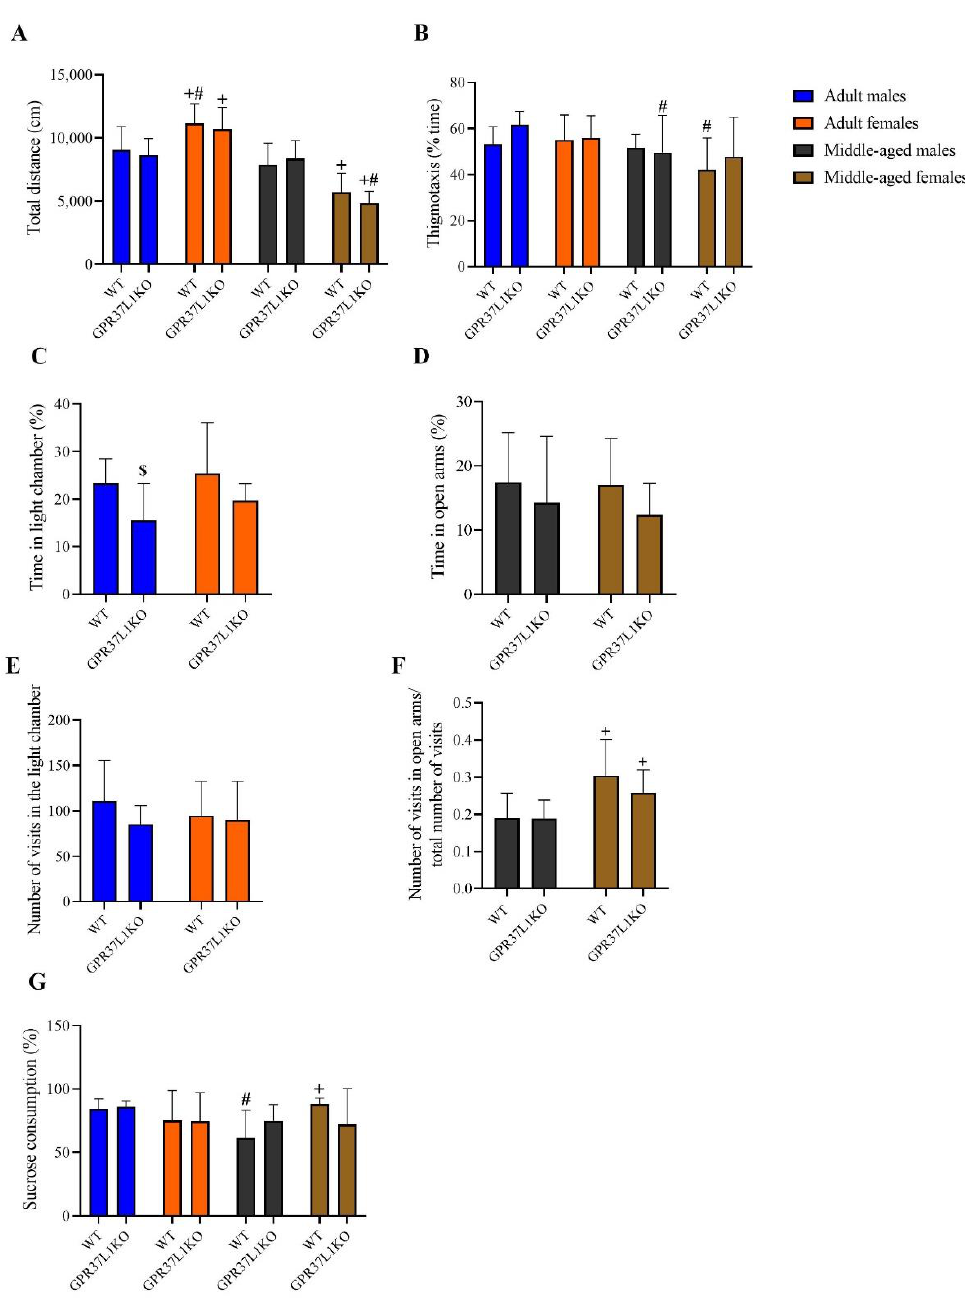
Figure 2. Effect on locomotion, anxiety and depression-like behaviour in adult and middle-aged WT and GPR37L1KO males and females. Total distance in open field ( A ). Percent time thigmotaxis behaviour in open field ( B ). Percent time spent in the light chamber in light dark box test ( C ). Percent time spent in the open arms in the elevated plus maze ( D ). Number of entries in the light chamber of the light dark box ( E ). Number of entries in the open arms of the elevated plus maze ( F ). Percent of sucrose consumption in sucrose preference test ( G ). n /group: 7 to 10. All data represent mean ± SD. # p < 0.05 versus corresponding age; + p < 0.05 with respect to sex; $ p > 0.05 < 0.1 with respect to